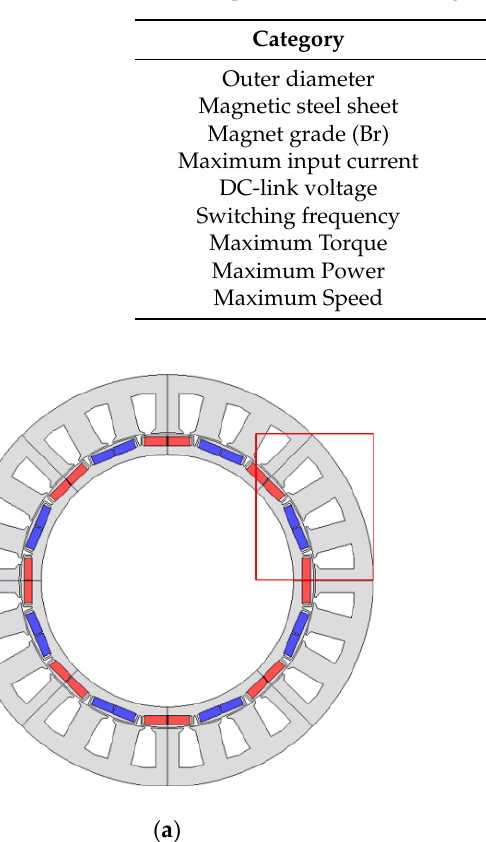
Figure 3. Topology of the designed model. ( a ) Full designed model; ( b ) Periodic part of the designed model.